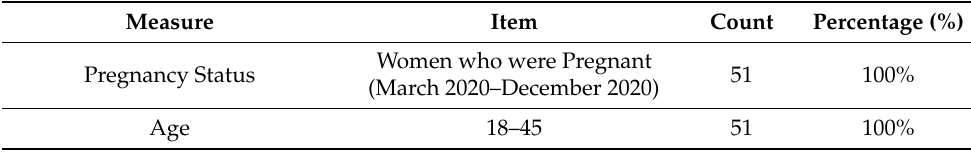
Table 1. Demographics Table. Measure